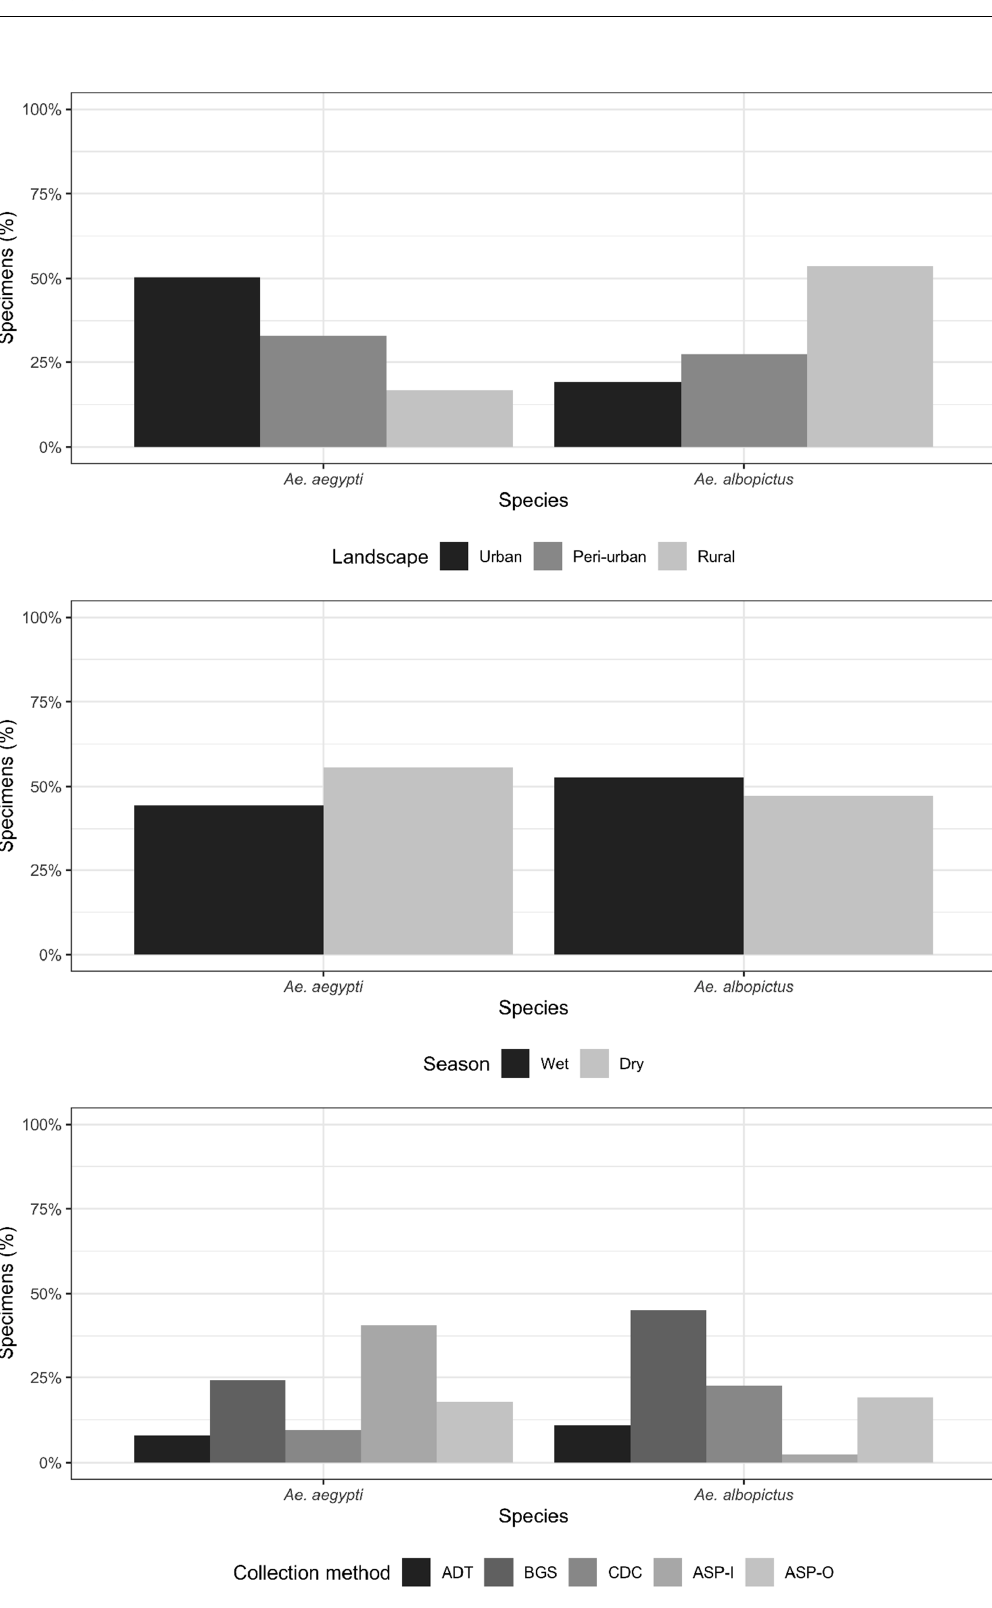
Figure 3. Exploratory analysis of the total number of Ae. aegypti and Ae. albopictus specimens collected in the study. Top: percentage of Ae. aegypti and Ae. albopictus specimens collected according to landscapes (urban, peri-urban and rural). Middle: percentage of Ae. aegypti and Ae. albopictus specimens collected according to season (wet and dry). Bottom: percentage of Ae. aegypti and Ae. albopictus specimens collected according to collection method (ADT, BGS, CDC, ASP-I and